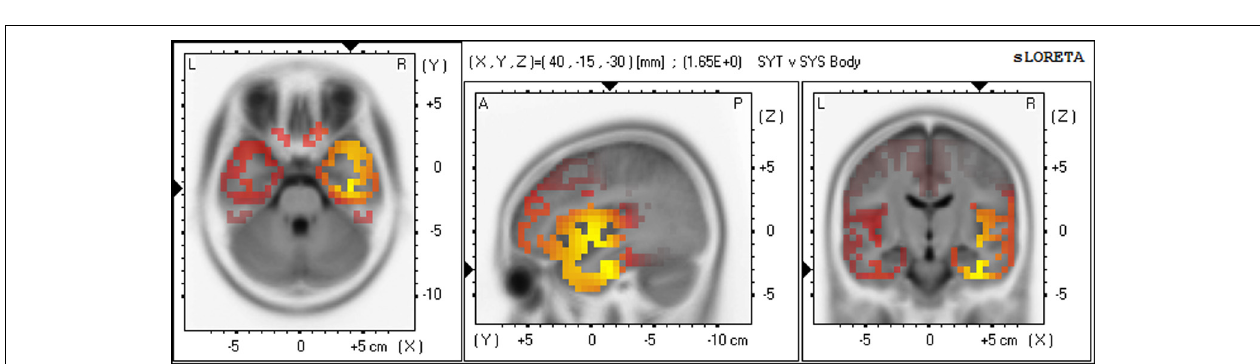
FIGURE 4 | Differences in CSD between groups in alpha1 band—Non-meditation (Calculation) Increased alpha1 activity (blue) in SYS compared to SYT in right BA6 (precentral gyrus).